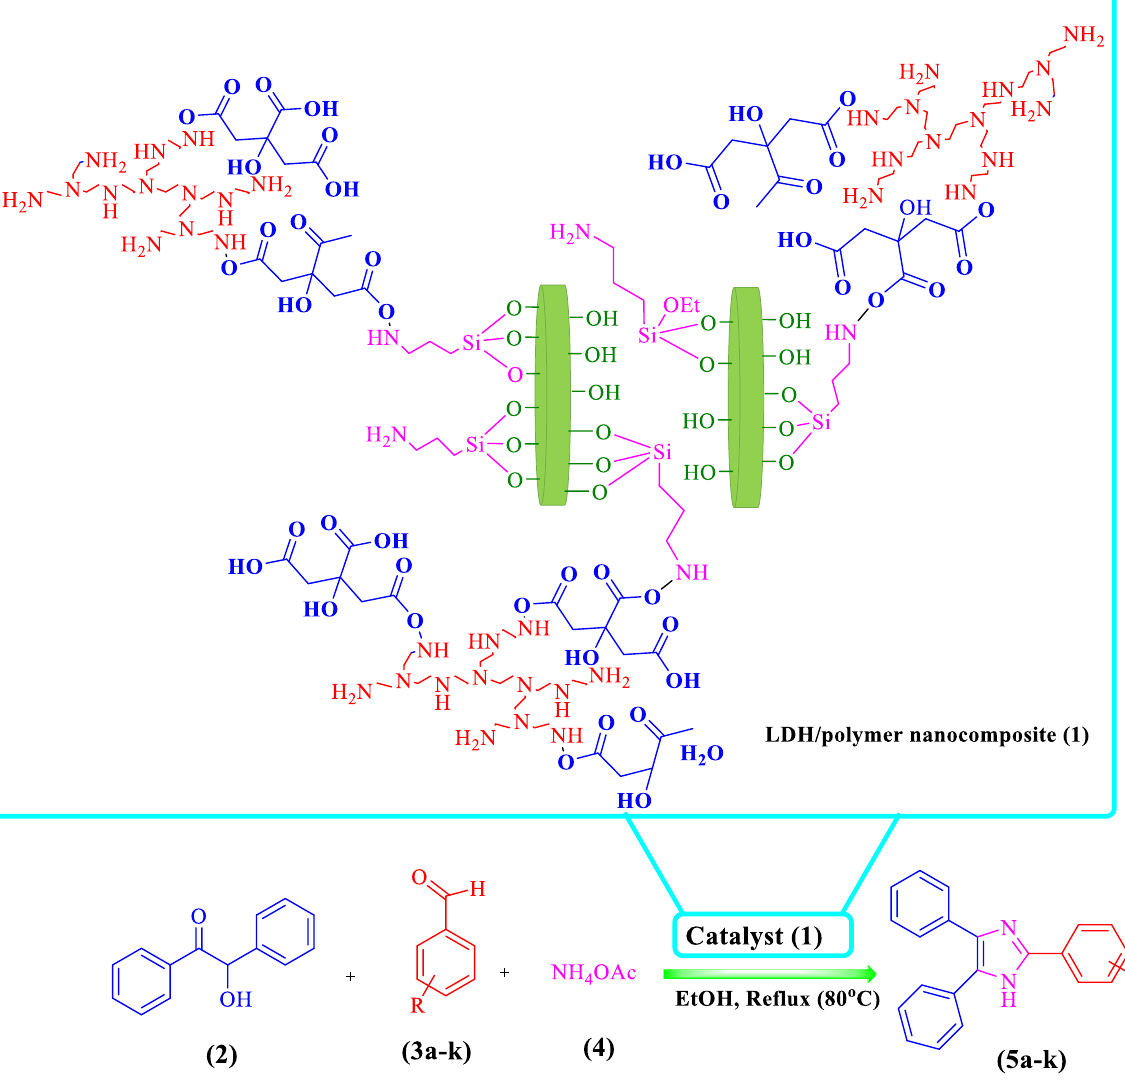
Figure 1. LDH–APS–PEI–DTPA nanocomposite ( 1 )-catalyzed synthesis of imidazole derivatives through a multicomponent reaction of benzoin ( 2 ), aldehyde derivatives ( 3a–k ), and ammonium acetate ( 4 ) in EtOH under reflux